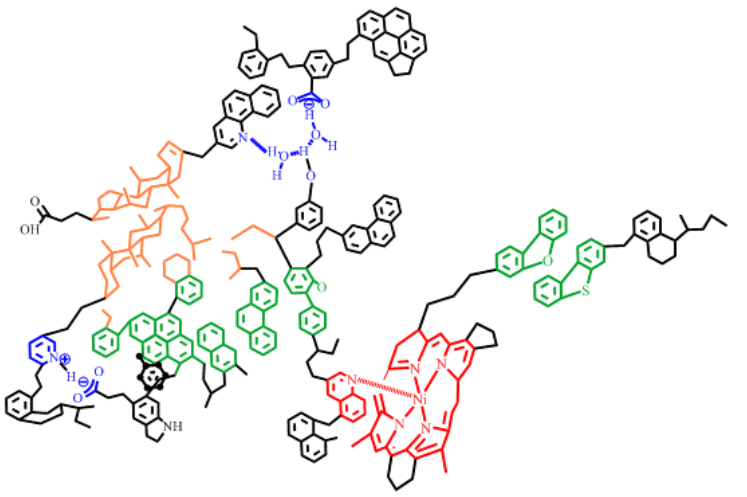
Figure 10. Proposed asphaltene molecular structure model. Reprinted with permission from Ref.